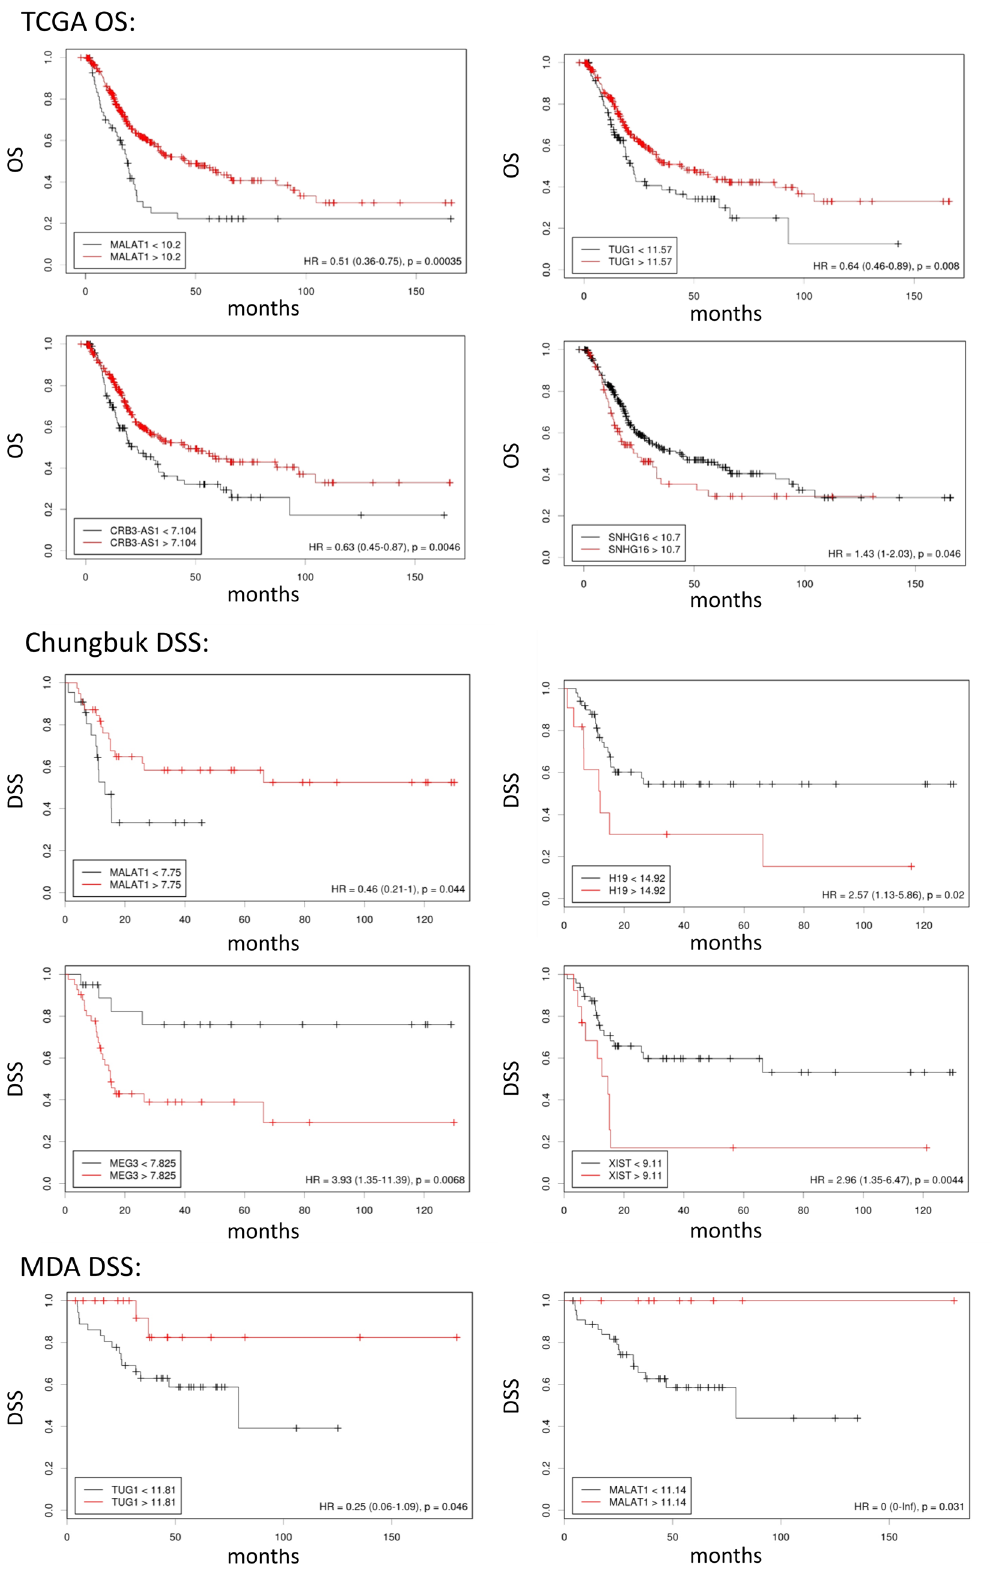
Figure 4. Kaplan Meier plots of lncRNAs allowing a significant risk stratification ( p < 0.05) based on high and low transcript level expression. In silico validation of lncRNA based survival prediction on behalf of the TCGA (n = 371, no DSS data available), Chungbuk (n = 61) and MDA (n = 55) cohort. Only genes with a valid cutoff are shown. OS overall survival, DSS Disease specific